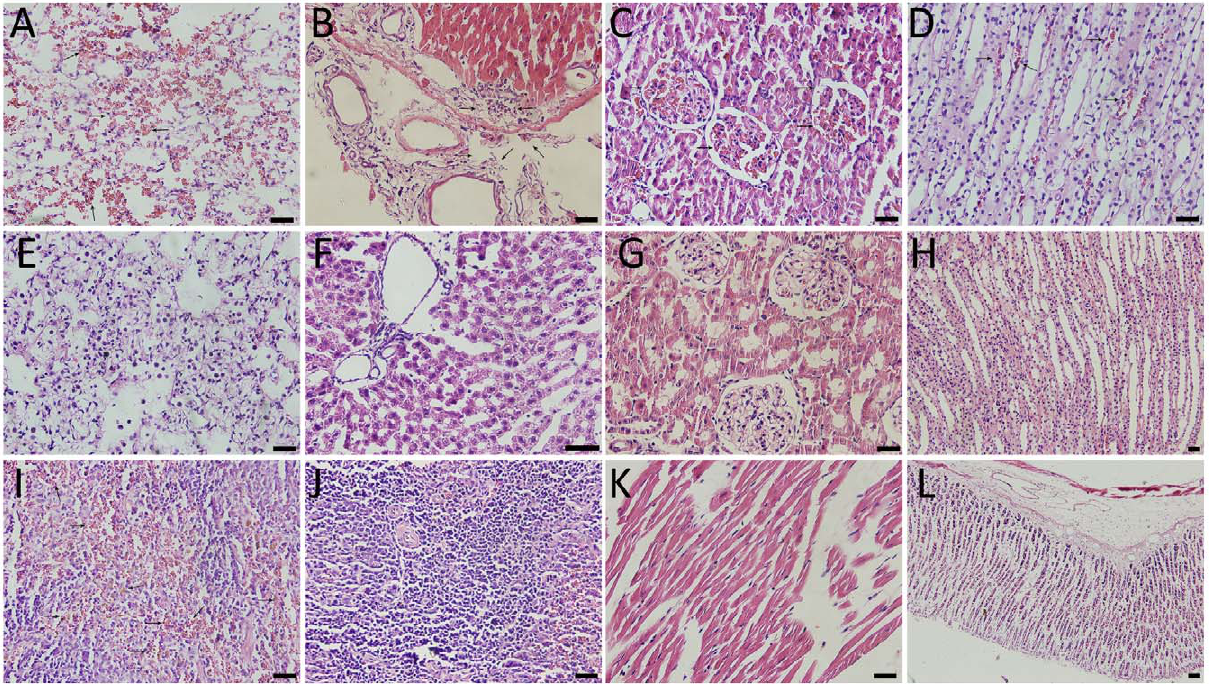
Figure 7. Pathological changes in peripheral organs of Parkinsonian rats. (A): Neutrophilic infiltration in the pulmonary alveoli; (B): neutrophil infiltration in the periportal areas, the expansion of central veins and bile ducts; (C) and (D): Red blood cells were increased in the renal glomeruli and renal medulla; (E): The normal alveolar walls were thin and delicate; (F): the normal hepatic lobules and central veins; (G) and (H): the normal renal glomerulus and renal medulla; (I): hemorrhage and hemosiderin deposition in the spleen of Rot-group rats; (J): the normal white pulp of the spleen; (K) and (L): normal heart and stomach of Rot-group rats (10 rats from ROT-group, 8 rats from Eda-group and 6 rats from Veh-group; Scale bars =50 m m).